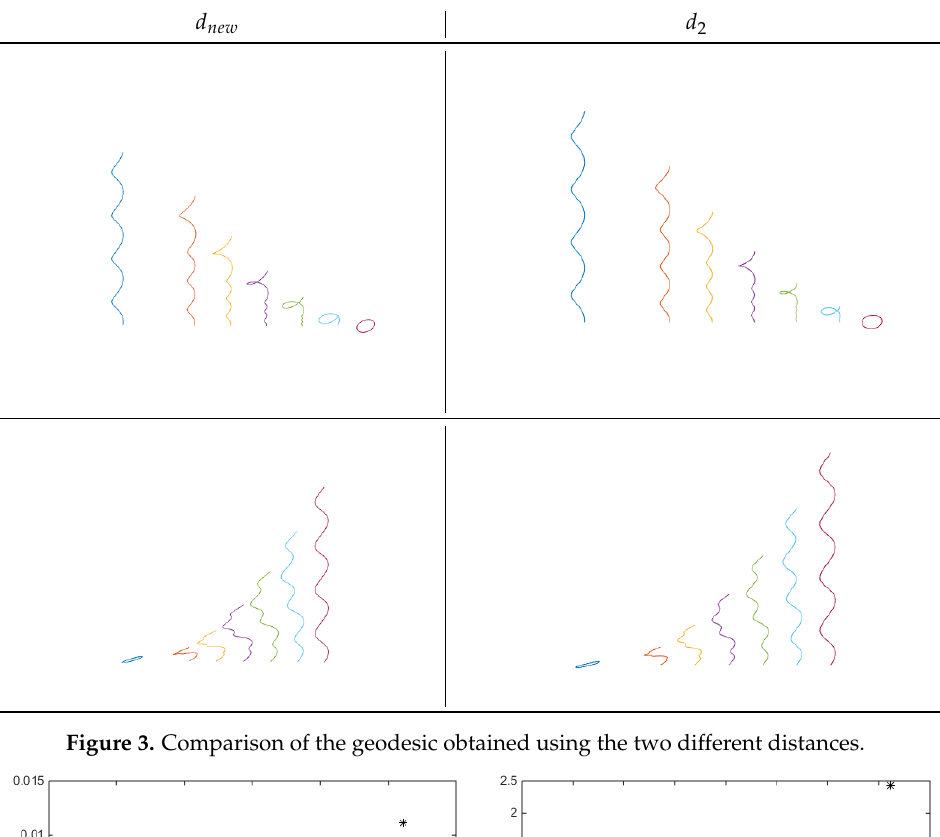
Figure 5. In both graphics, the initial spirals { β i 1 } i = 1, ··· ,10 are plotted in green; the circumferences { β } i 2 i = 1, ··· ,10 are plotted in black, and their scaled versions, plotted in red and blue color,